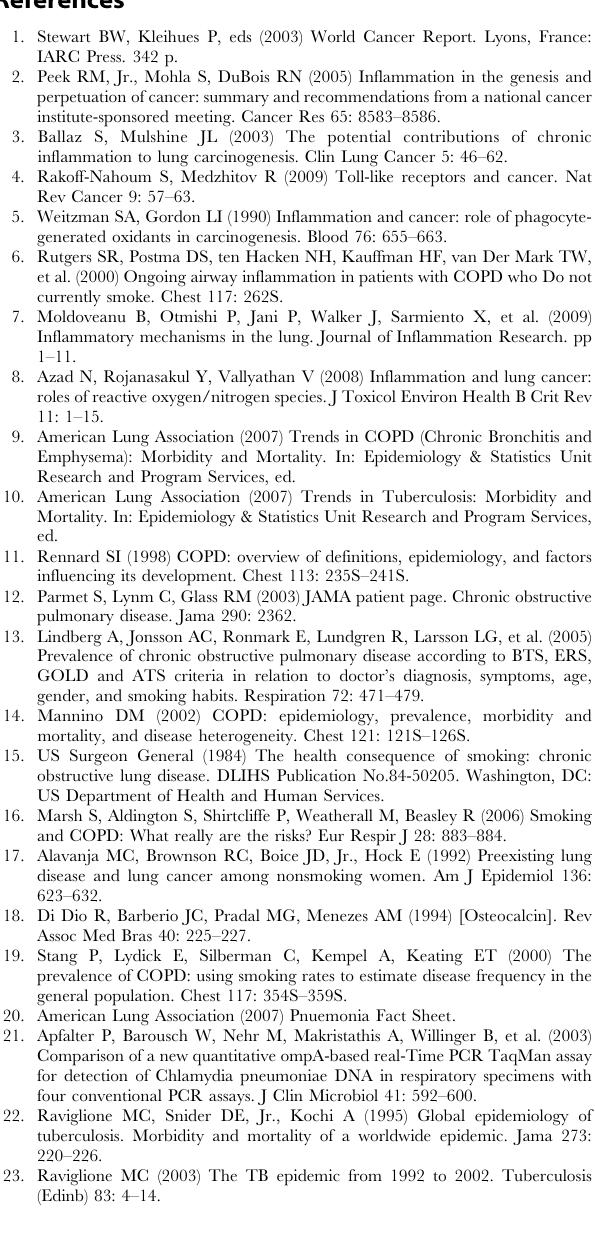
Figure S10 Funnel plot of the effects of emphysema across studies.